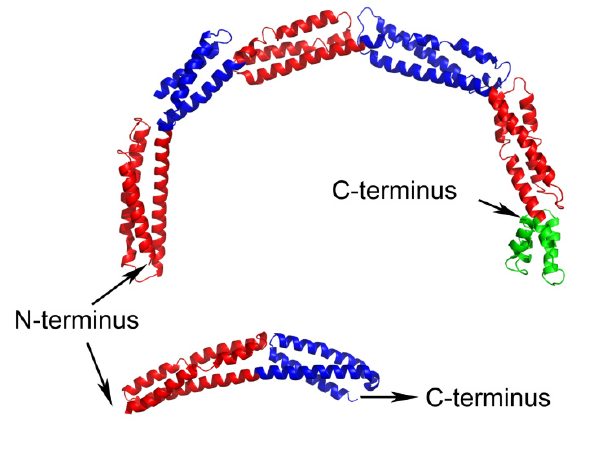
FIGURE 1: Structures of B. subtilis (top) and S. aureus (bottom) EzrA cytoplasmic domains. The five ~100 amino acid triple helical bundle repeat units in B. subtilis EzrA are coloured alternately red and blue; the terminal 4 helical bundle is coloured green. The S. aureus EzrA structure is an N-terminal fragment of the cytoplas- mic domain, encompassing just two of the five triple helical bun- dle